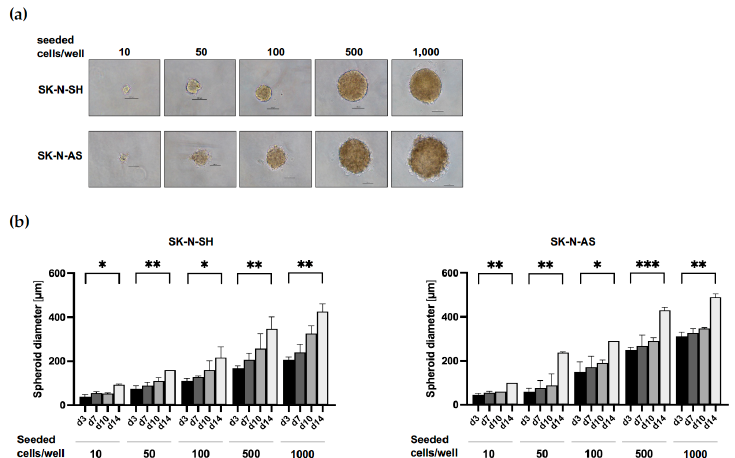
Figure 1. Establishment of spheroid culture conditions. ( a ) Phase-contrast imaging of SK-N-SH spheroids on day 7 and SK-N-AS spheroids on day 10 after seeding increasing cell numbers on round-bottom 96-well ULA plates. Scale = 100 µ m. ( b ) Analysis of the diameter of SK-N-SH ( left ) and SK-N-AS ( right ) spheroids seeded with increasing cell numbers and grown on round-bottom 96-well ULA plates for 3 days (d3), 7 days (d7), 10 days (d10) and 14 days (d14). Three independent experiments (n = 3) in triplicate were performed. Degrees of significance (unpaired student’s t -test): * < 0.05, ** < 0.01 and *** < 0.001. Table 1. Summary of optimal 3D culture conditions for five neuroblastoma cell lines and average spheroid size (diameter) after 3 days (d3) and 7 days (d7) of culture growth.